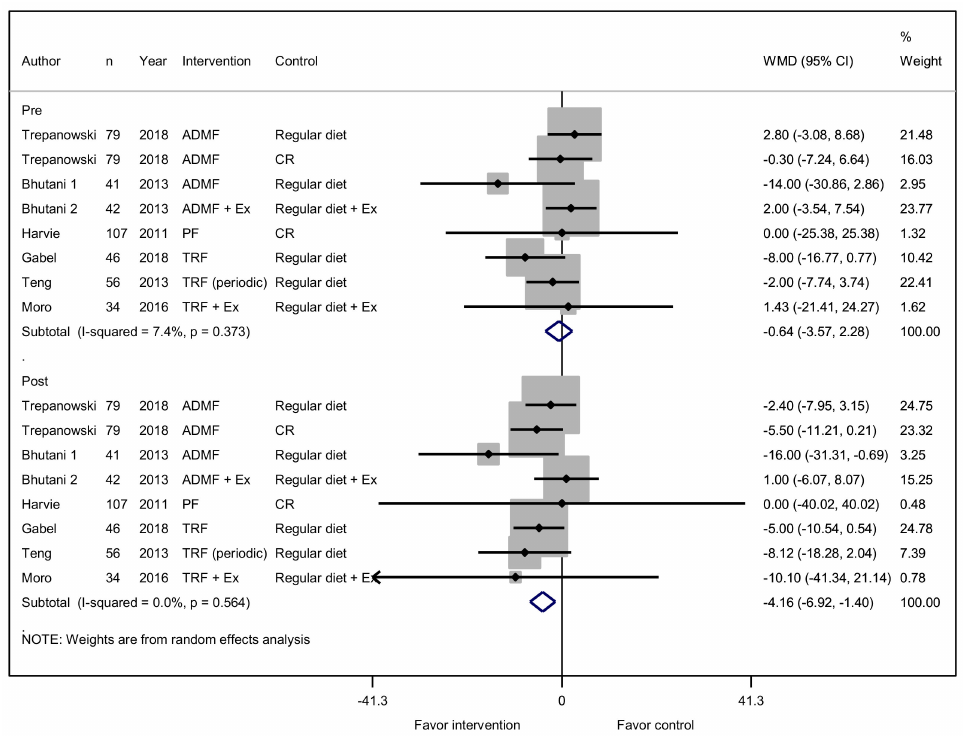
Figure 3. E ff ect of IF versus non-fasting control on fasting blood glucose (changes from baseline) in adults without chronic metabolic disease.